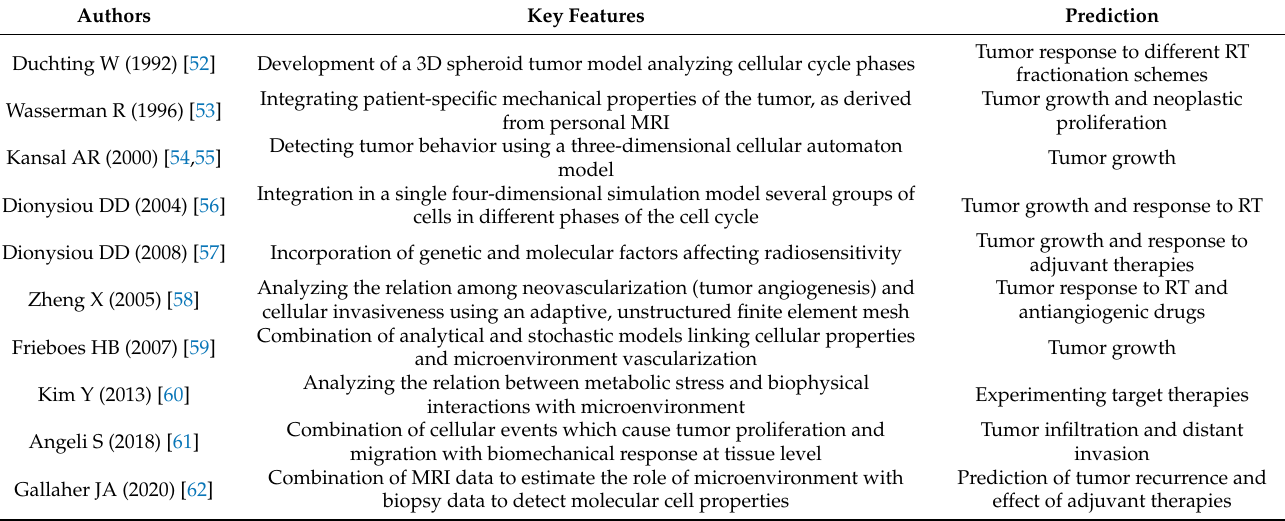
Table 2. Principal innovation in the discrete and hybrid mathematical models of